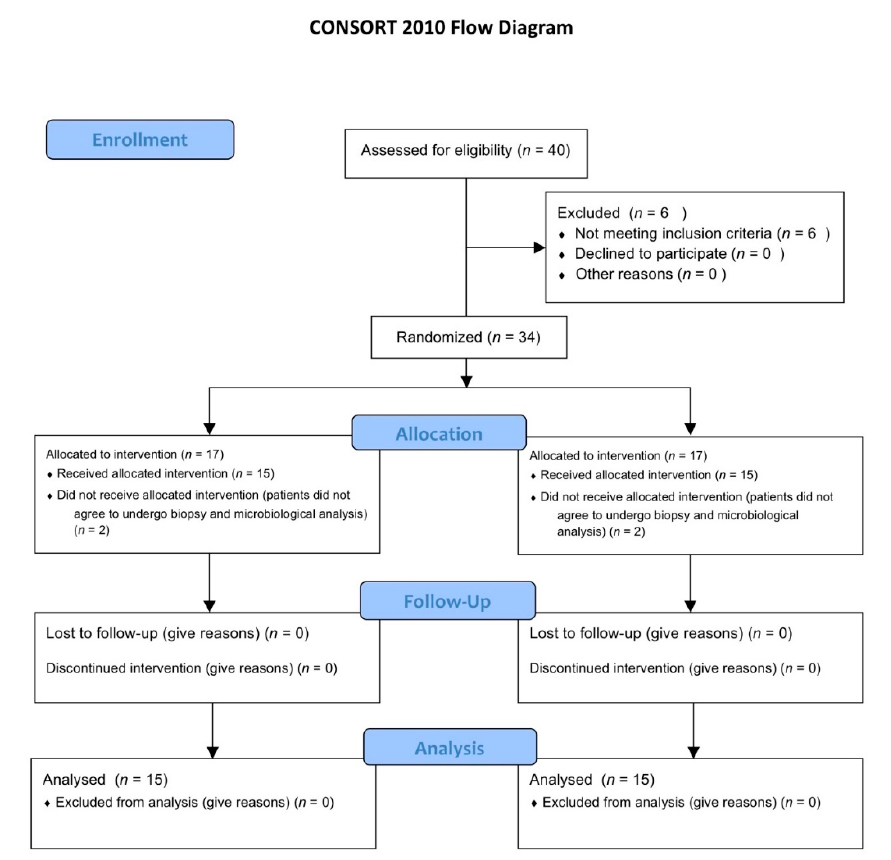
Figure 1. CONSORT 2010 flow diagram. Flow diagram of the progress through the phases of a parallel randomized trial of two groups.